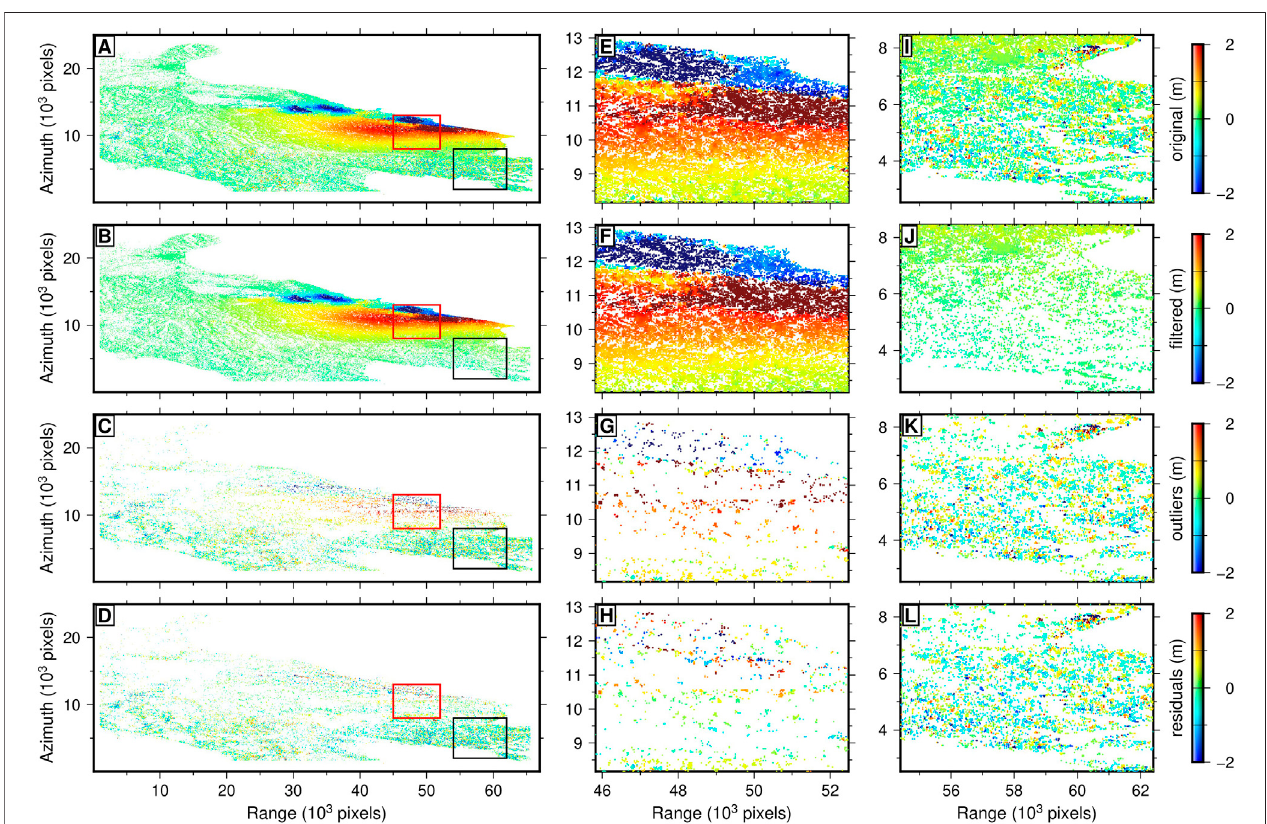
FIGURE5 | Quadtree fi ltering for range offsets. (A) Range offsets before and (B) after quadtree fi ltering. (C) Pixels removed by the fi lter. (D) Residualsbetween the observed offsets of the outliers and the mean of their associated quadrant. Red and black boxes in the fi rst column correspond to near- fi eld and far- fi eld data, the corresponding fi gures are shown in (E – H) and (I – L) ,